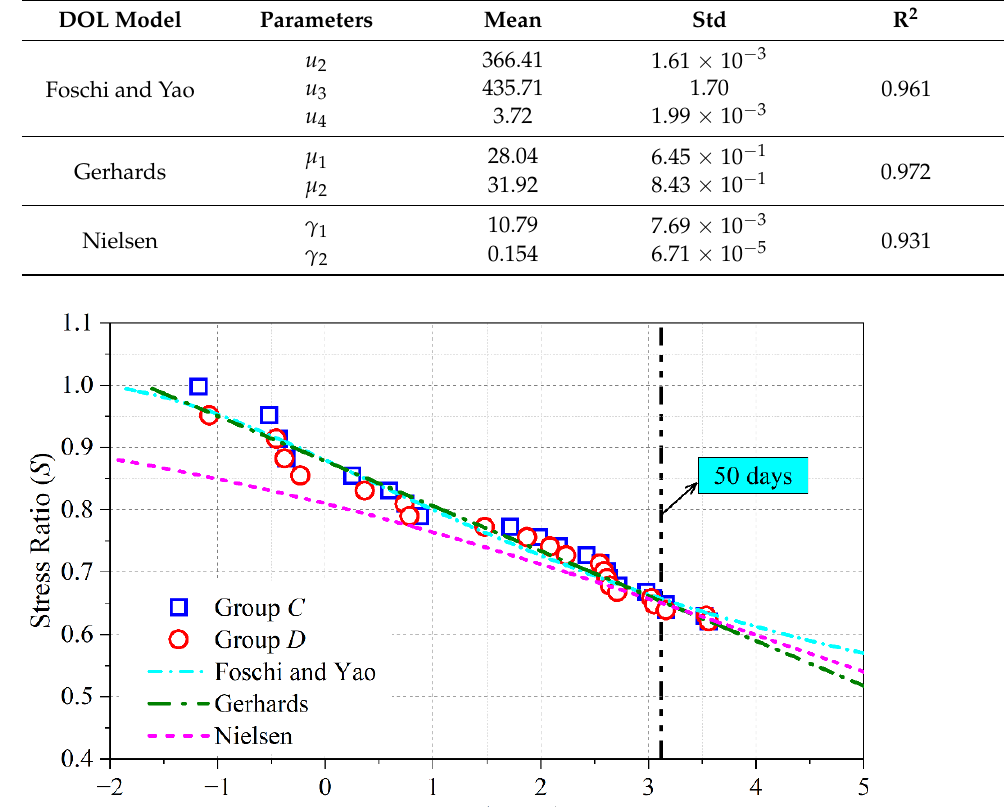
Table 2. Parameters of different DOL models.